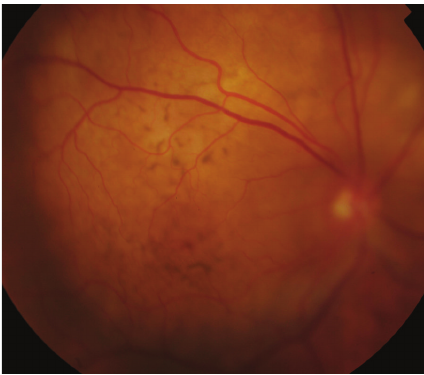
Figure 1: Fundus photograph of the right posterior pole (focused anteriorly on the elevated retina): multiple cream-coloured cho- roidal lesions with fine retinal pigment epithelial mottling.